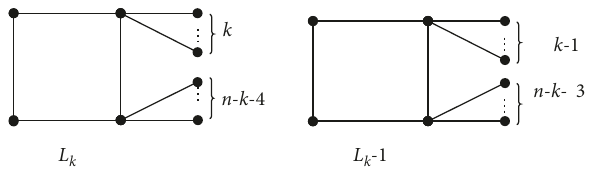
Figure 5: Graph transformation in Theorem 4.